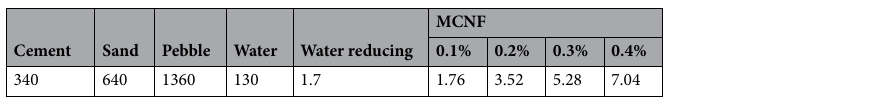
Table 3. The mix ratio of concrete (kg/m 3